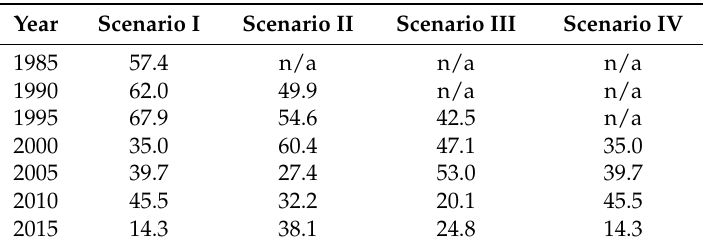
Table 10. Infiltration in different scenarios (Unit: m 3